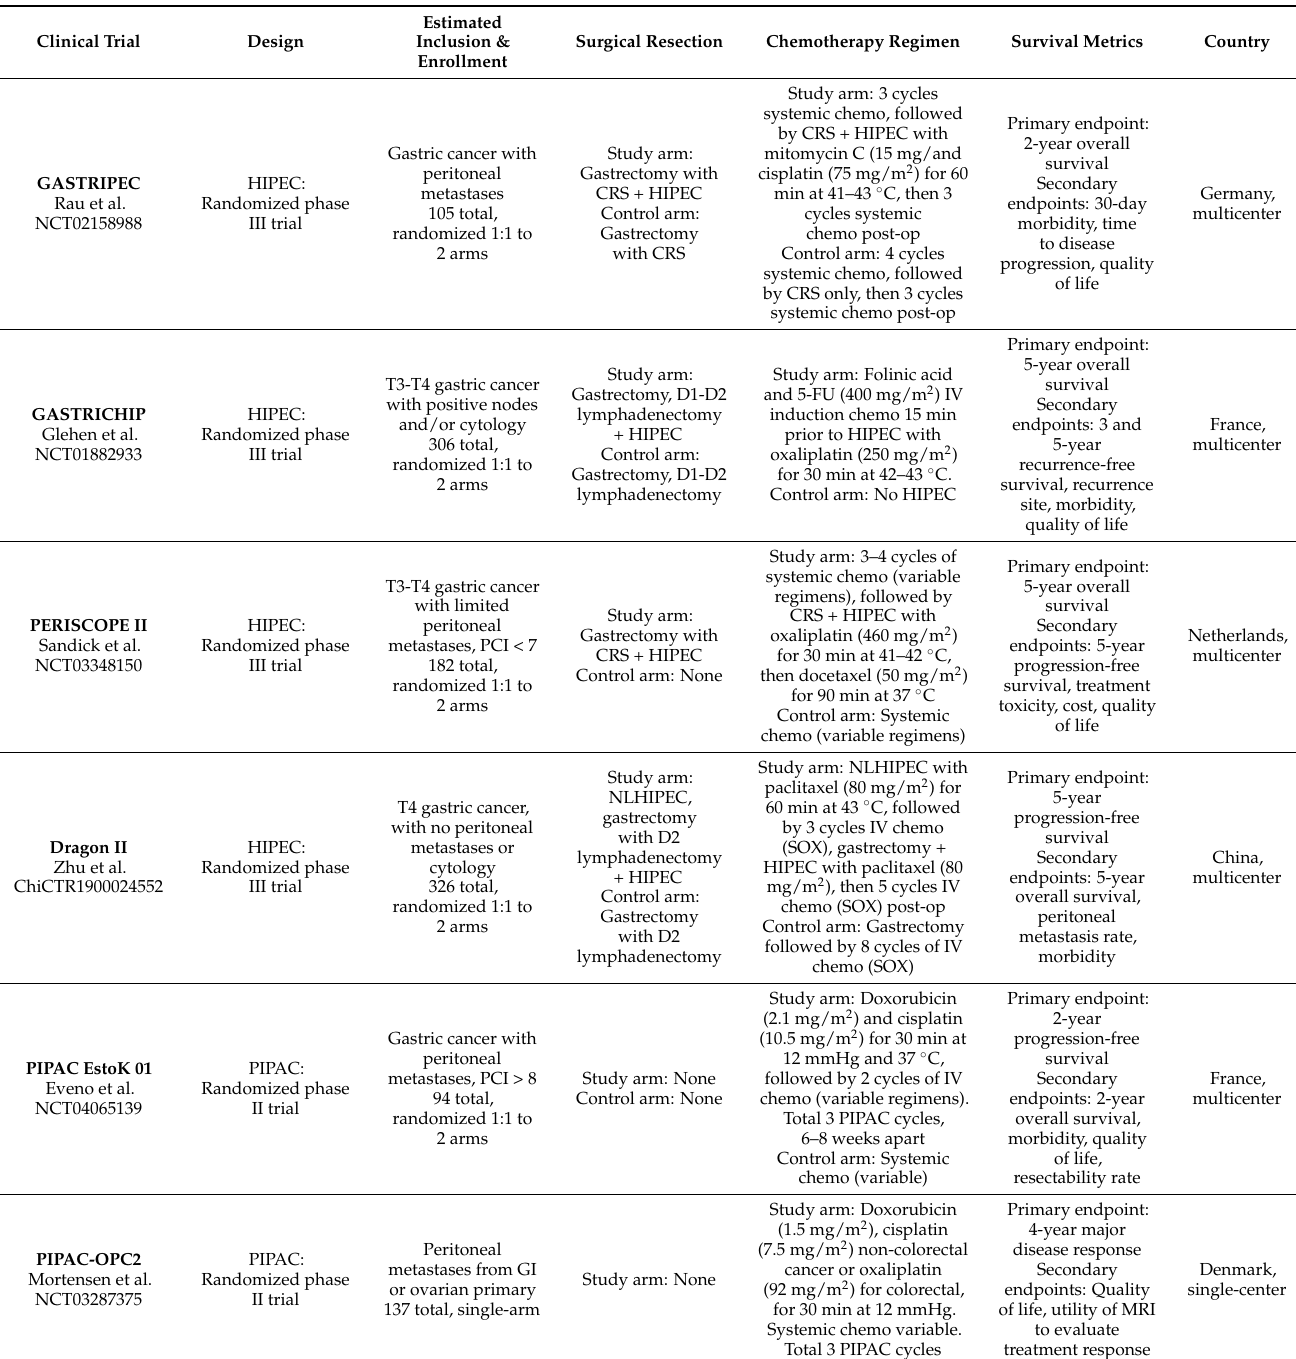
Table 3. Summary of Ongoing Clinical Trials in Intraperitoneal Chemotherapy in Gastric